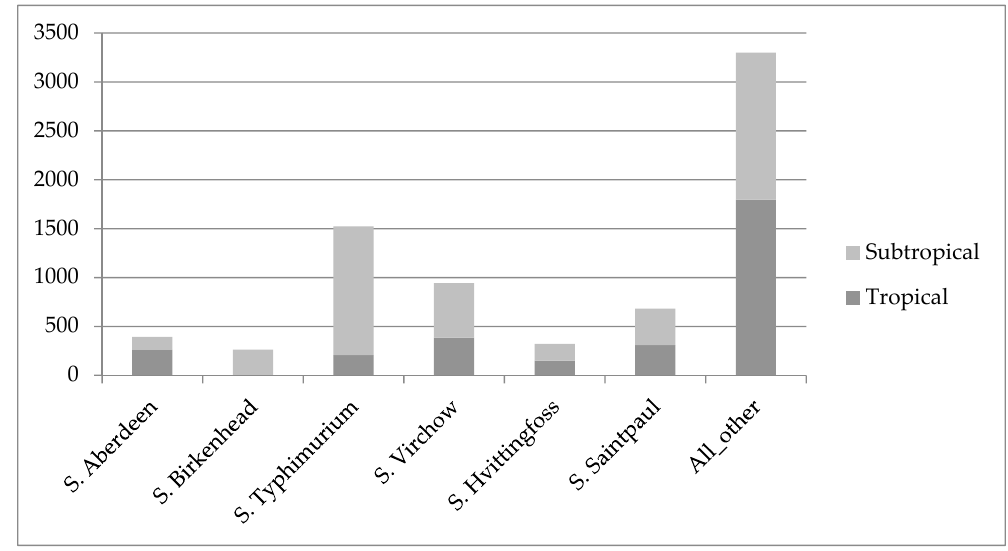
Figure 4. Distribution of faecal Salmonella spp. serovars in the tropical and the sub-tropical regions. The four most common serovars across the entire data set were S . Typhimurium, S . Virchow,